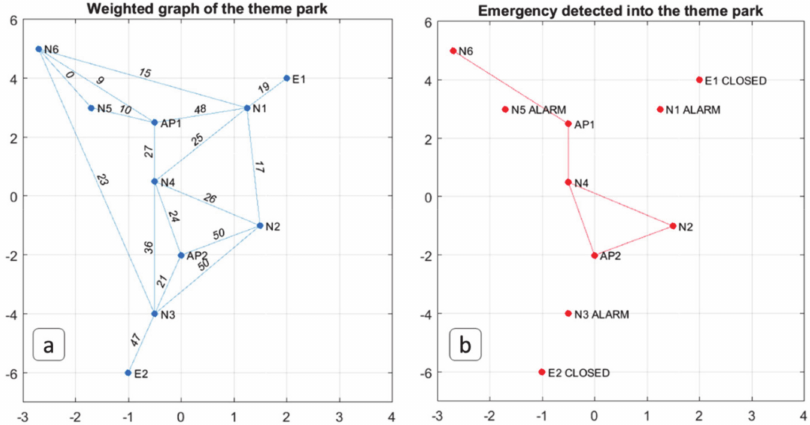
Figure 16. Example of the results of the Algorithm 3 in case of an environmental / structural alarm at nodes 1, 3, and 5 (N1, N3, and N5), where ( a ) is the graph before the alarm triggering and ( b ) is the graph after the alarm triggering.